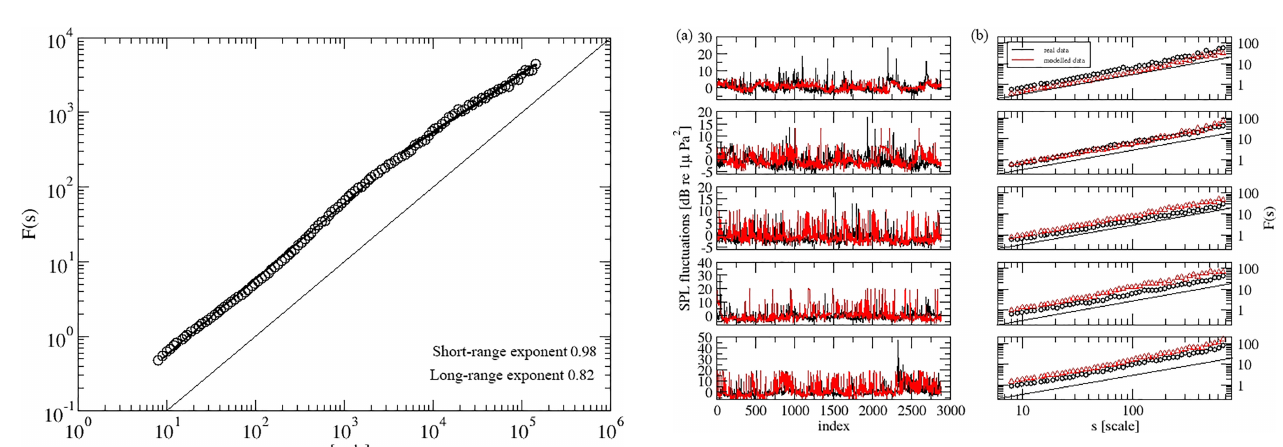
Figure 7. Detrended fluctuation analysis scaling curve of the broad- band SPL, with estimated scaling exponent values. The straight line denotes the slope with scaling exponent 1. The scaling exponents of the curve (short term and long term) are much higher than 0.5, hence the noise is not white but red (presence of correlations); the exponent is slightly smaller than 1, which means that the fluctua- tions are stationary (unlike a nonstationary random walk).